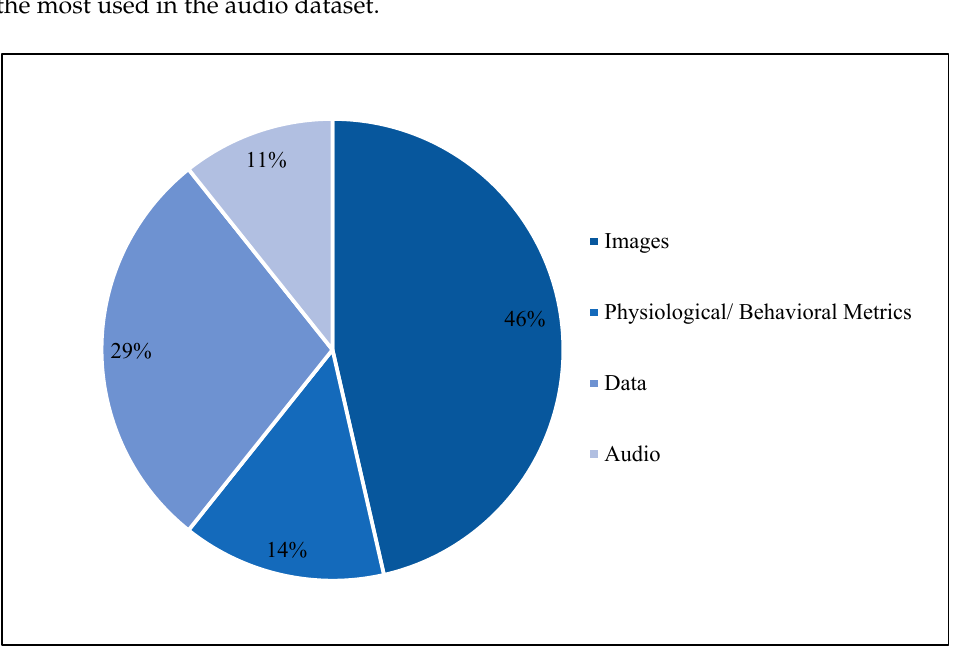
Table 4. Summary of datasets used in TinyML studies including input type.